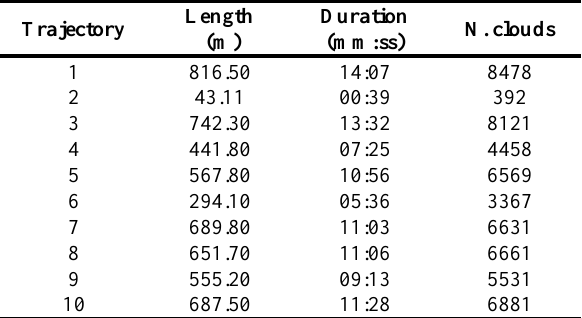
Table 1. Characteristics of the 10 trajectories performed with Gexcel Heron MS Twin Color.